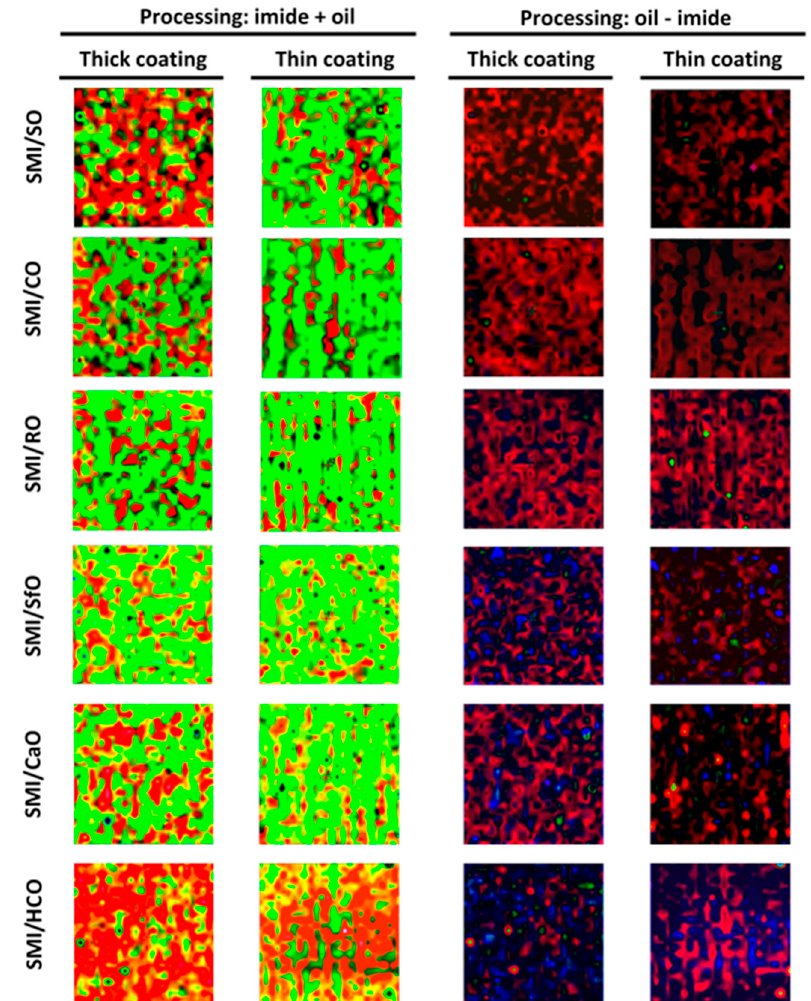
Figure 10. Processed images of single Raman wavenumbers for imide (1765 cm − 1 ) and oil (1655 cm − 1 ), illustrating lateral distribution of oil within the organic phase (+) and free oil ( − ).